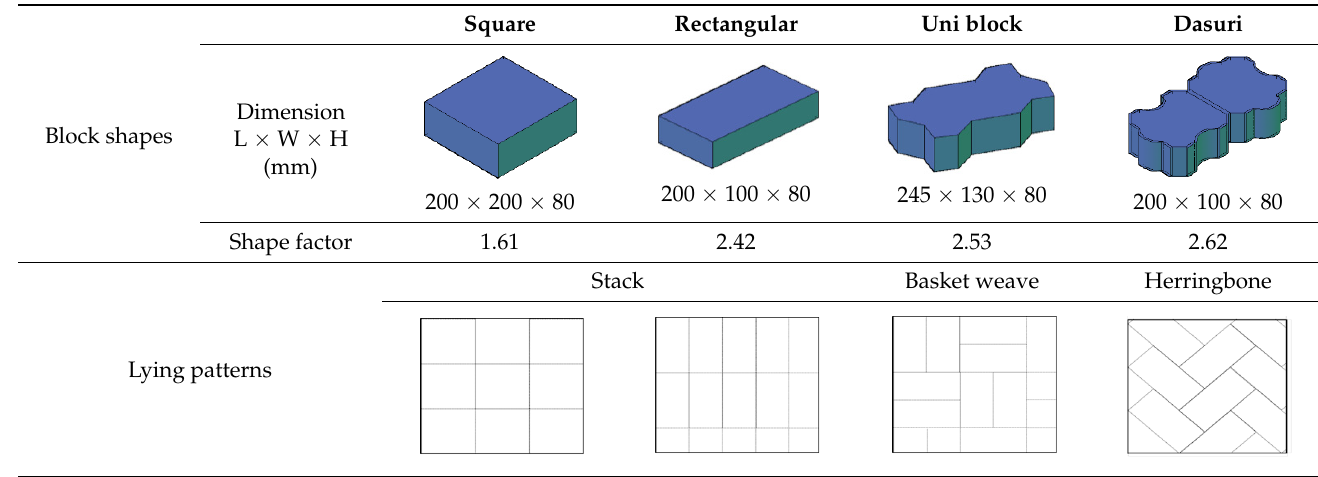
Table 2. Block shapes and patterns for joint performance evaluation.